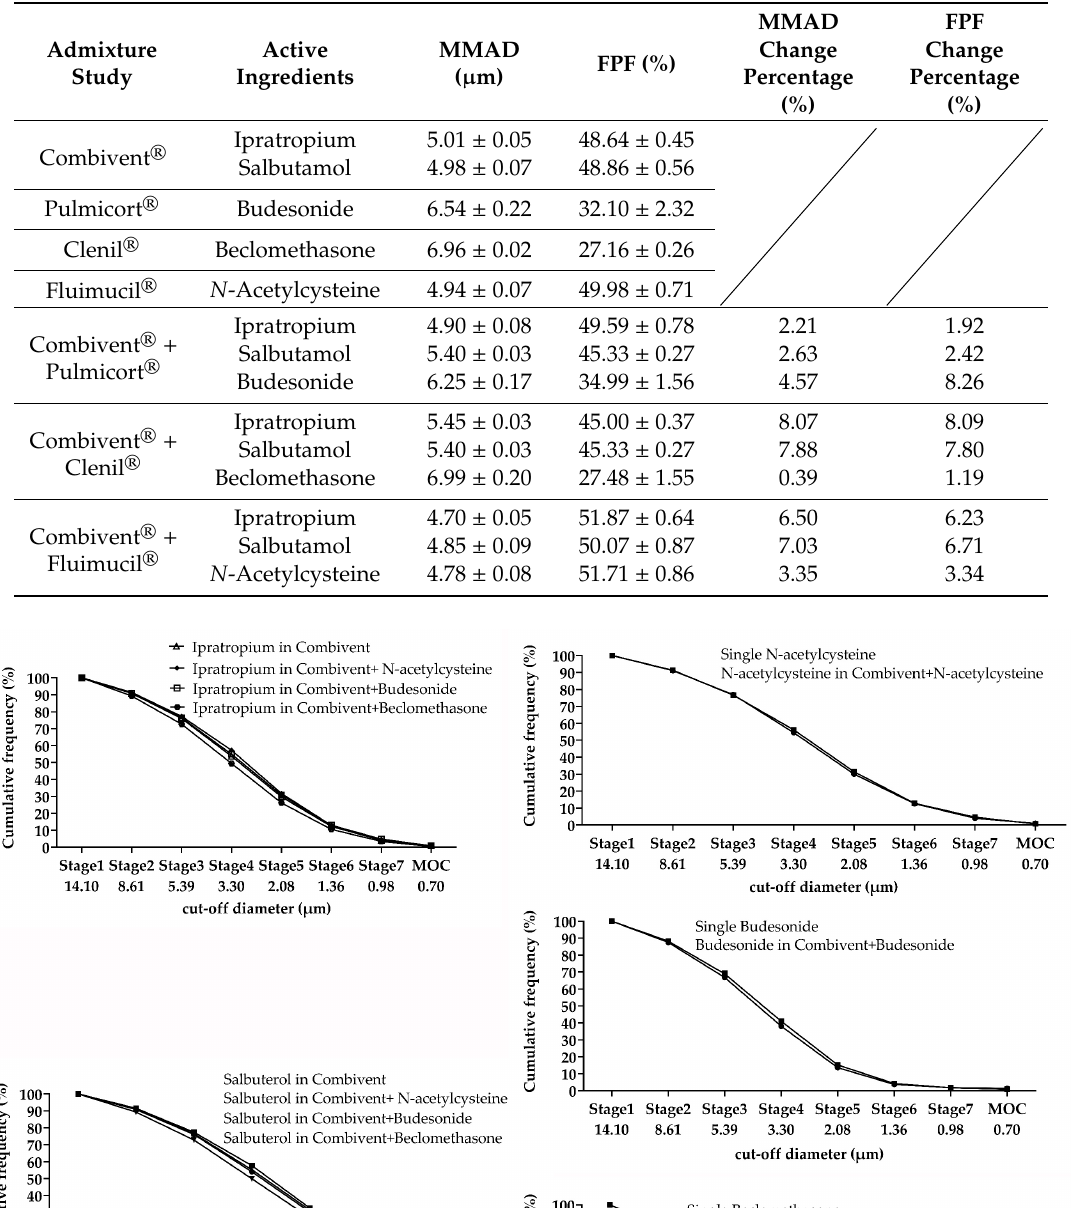
Table 6. MMAD and FPF and their change percentages for the single and mixed inhalation solutions / suspensions.